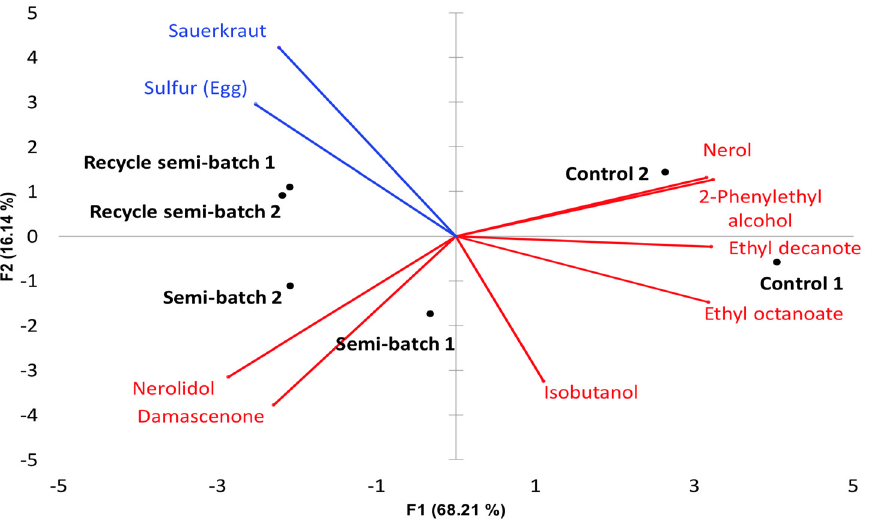
Figure 3. Principal Component Analysis (PCA) of seven volatile compounds (red) and two sensory aroma attributes (blue) of six FPI Chardonnay wines (black) that discriminated them significantly at p < 0.05. The PCA explained 84.35% of the total variation, 68.21% was explained in the first dimension, and 16.14% in the second dimension.